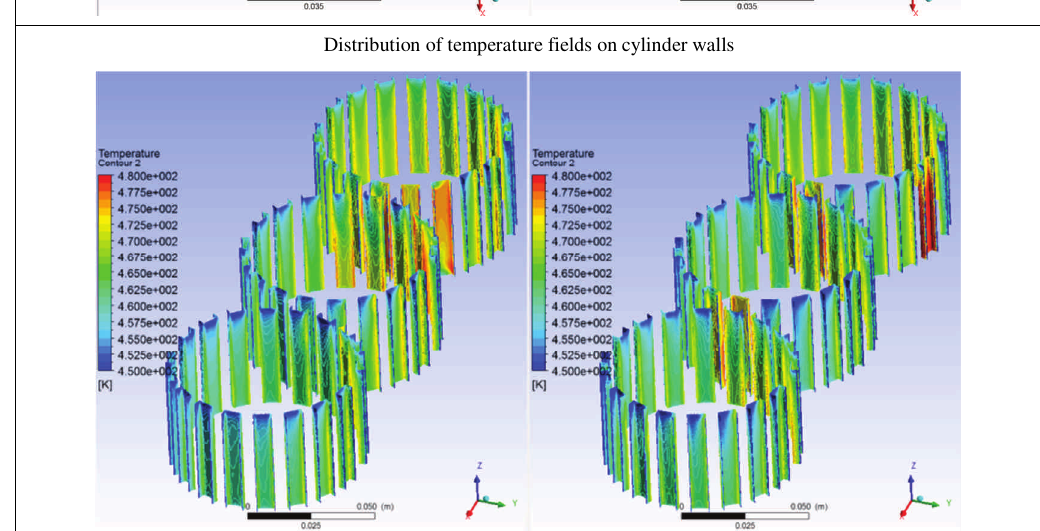
Fig. 15. Comparison of distribution of velocity field across ribs and temperature fields for model with variable geometry of the intake and outlet